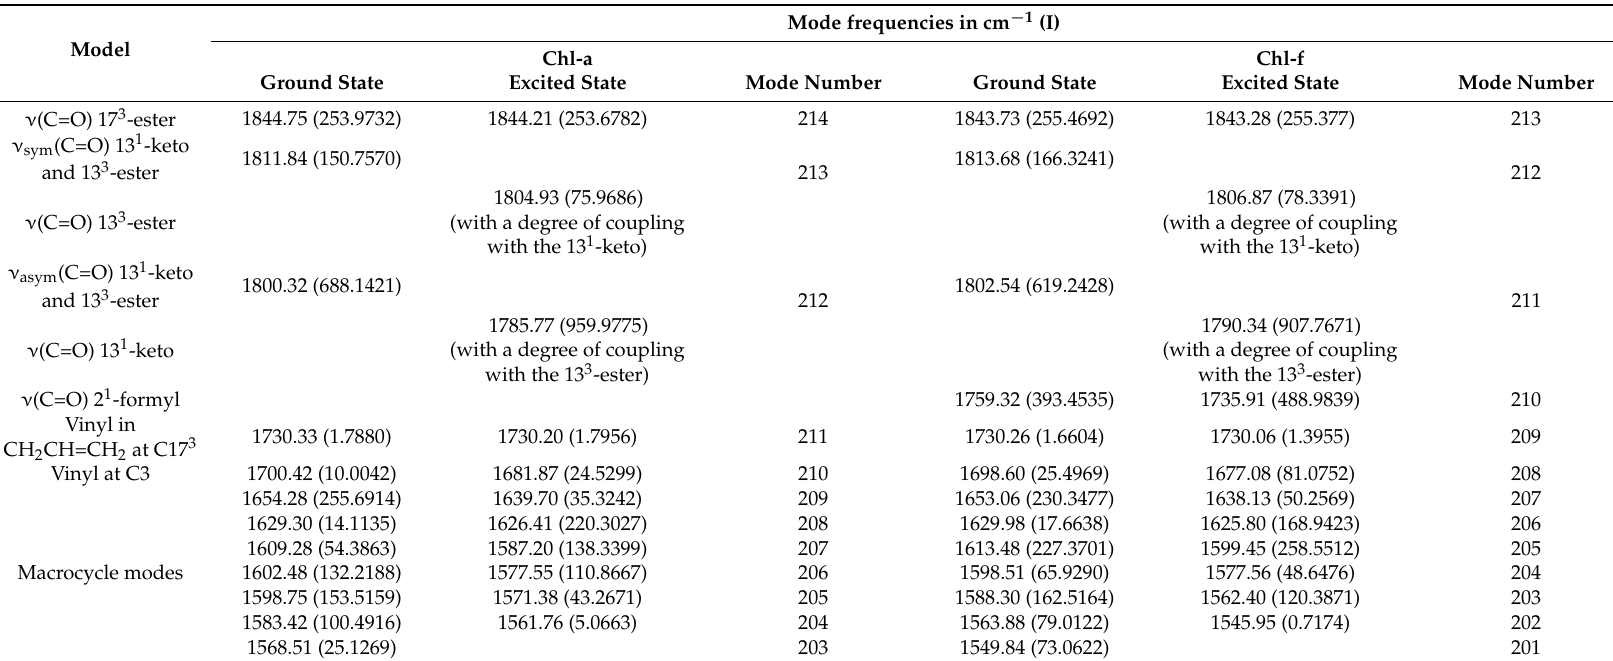
Table 2. Vibrational mode frequencies (unscaled) calculated for the ground state and excited state chlorophylls a and f using the B3LYP method and 6-31G(d) basis set, with corresponding mode assignments. Intensities (in km/mol) are shown in